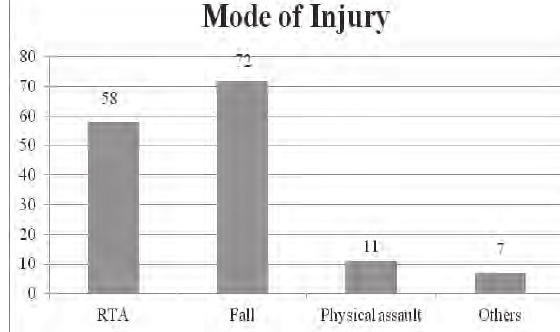
Figure 4: Figure showing frequency of patients with different modes of